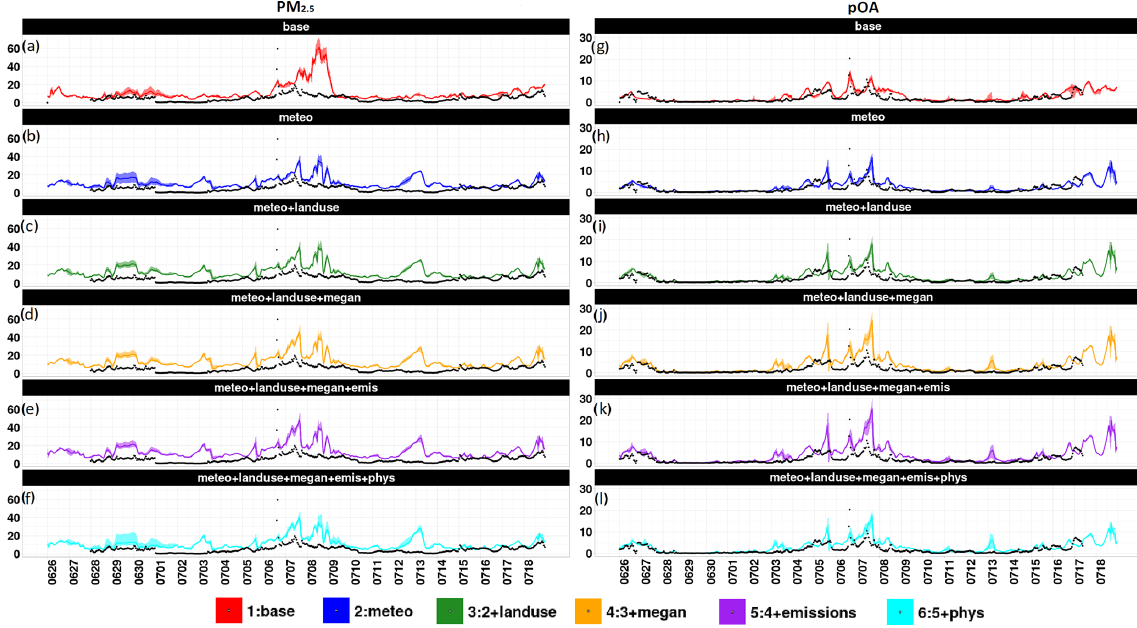
Figure 9. Time series for PM 2 . 5 and organic aerosols (OA) (both in µgm − 3 ) for all the sensitivity cases explained above. The color schemes are shown at the bottom. The name of each case is written above each time